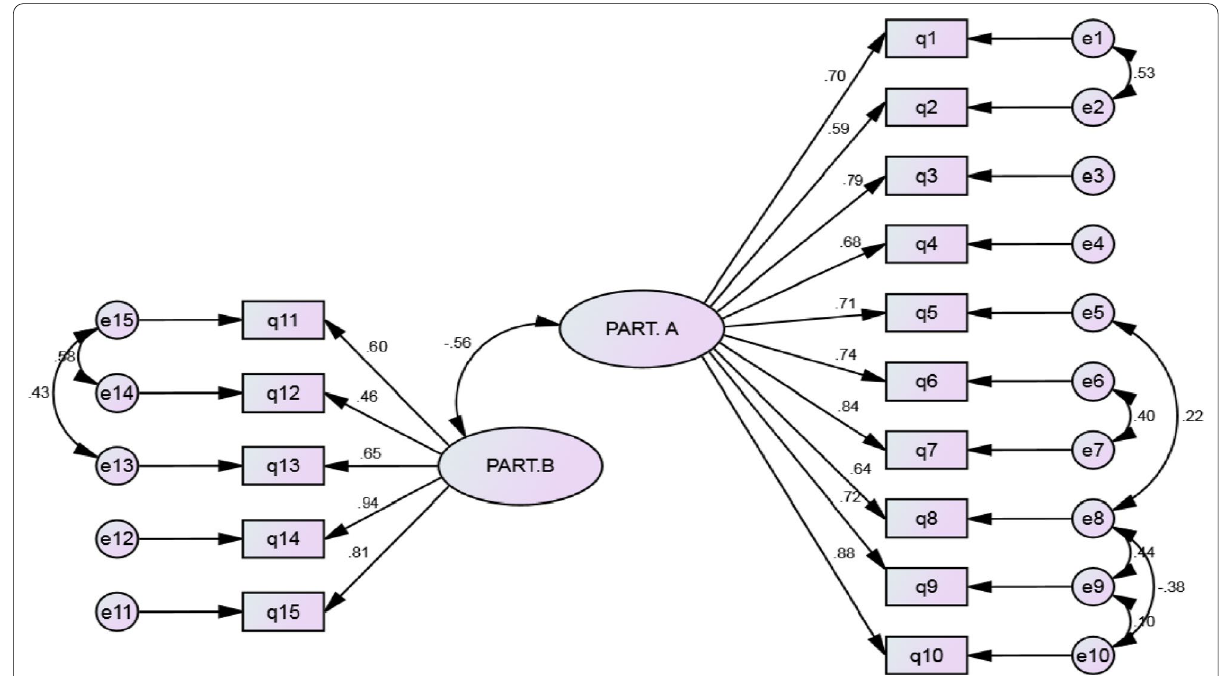
Fig. 2 QoR-15 questionnaire: modified model of first-order